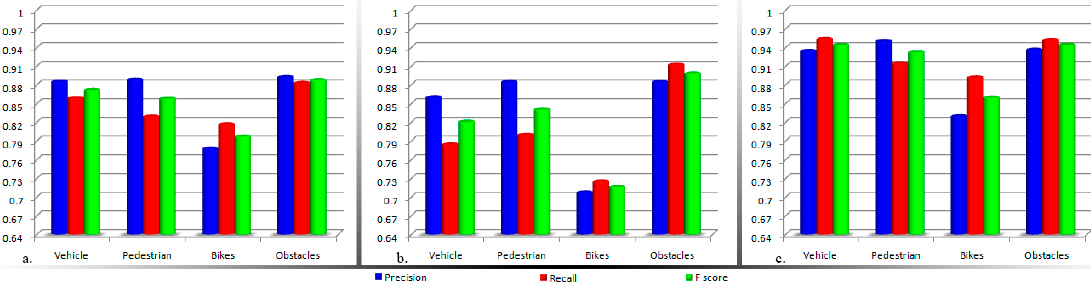
Figure 10. Experimental evaluation of the obstacle detection module, when activating: ( a ) The computer vision system; ( b ) The sensor network; ( c ) The overall framework.